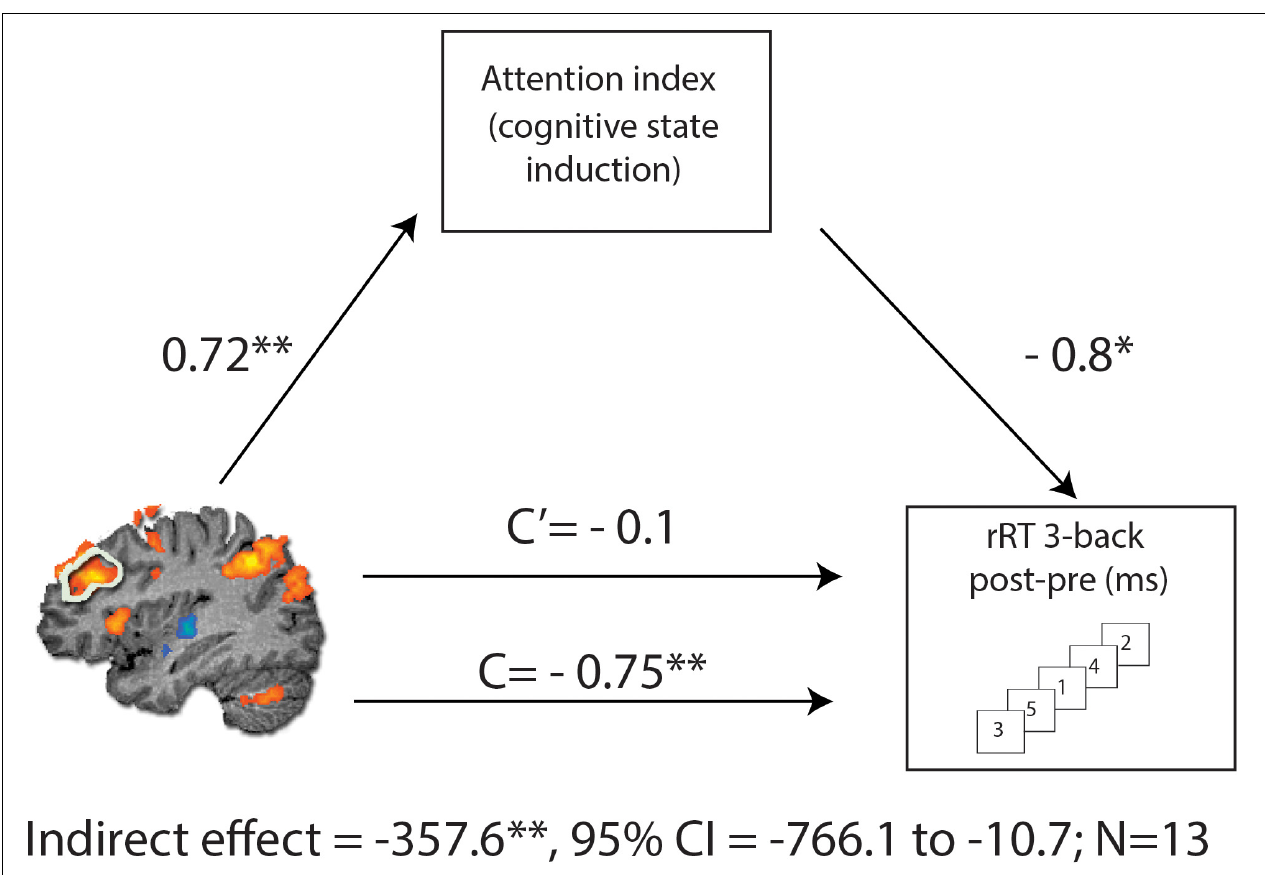
FIGURE 5 | Mediation analysis, describing possible causal mechanisms by examining variables that partially or fully account for the relationship between two variables. C represents the direct effect of rDLPFC beta difference on change in RT for the 3-back condition, while C’ represents the indirect effect, when including the NeuroTrax attention index in the model. Including the attention index in the model results in a non-significant effect (C’), consistent with the mediation hypothesis. The indirect effect was tested using a bootstrap approach with 10000 samples. The model is considered significant since its 95% bootstrap CI from 10000 iterations did not include zero at p = 0.05. * p < 0.05 and ** p <